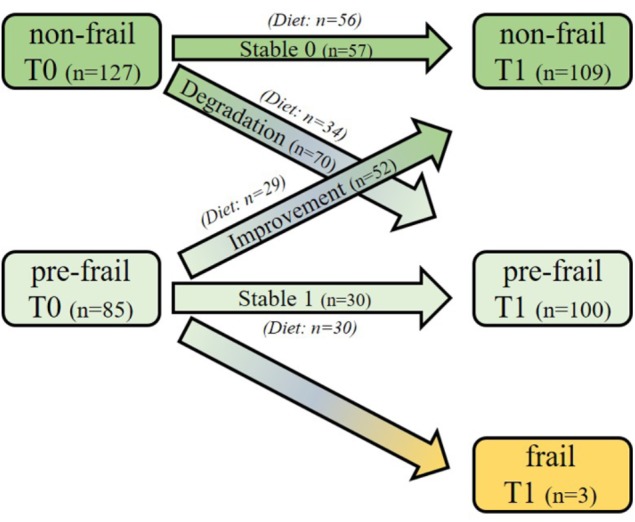
Study design and frailty status evolution of the subjects over the 1-year period. One hundred and twenty subjects (60 pre-frail and 60 non-frail) were first randomly selected at baseline among the intervention group from the Italian and Polish centers. In addition, all the remaining incident subjects shifting their frailty status during the follow-up (n = 92; n = 67 non-frail and n = 25 pre-frail) were also selected from the same centers, regardless of their intervention groups. Three sub-groups were defined: Stable subjects, who did not change their frailty status over time [Stable 0 (n = 57; 56 of them followed the NU-AGE diet); Stable 1 (n = 30, all of them followed the diet)], those who changed their status from pre-frail to non-frail [Improvement (n = 52, 29 of them were in the NU-AGE diet group)] and those who changed from non-frail to pre-frail [Degradation (n = 70, 34 of them followed the NU-AGE diet)] over 12 months.